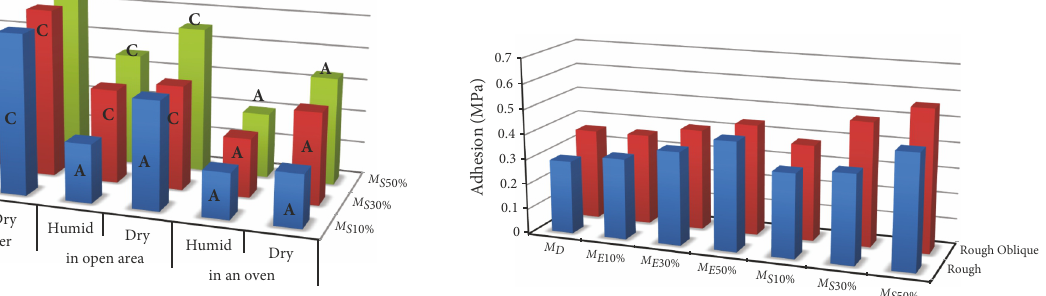
Figure 6. Influence of the roughness and failure mode on the mortar adhesion